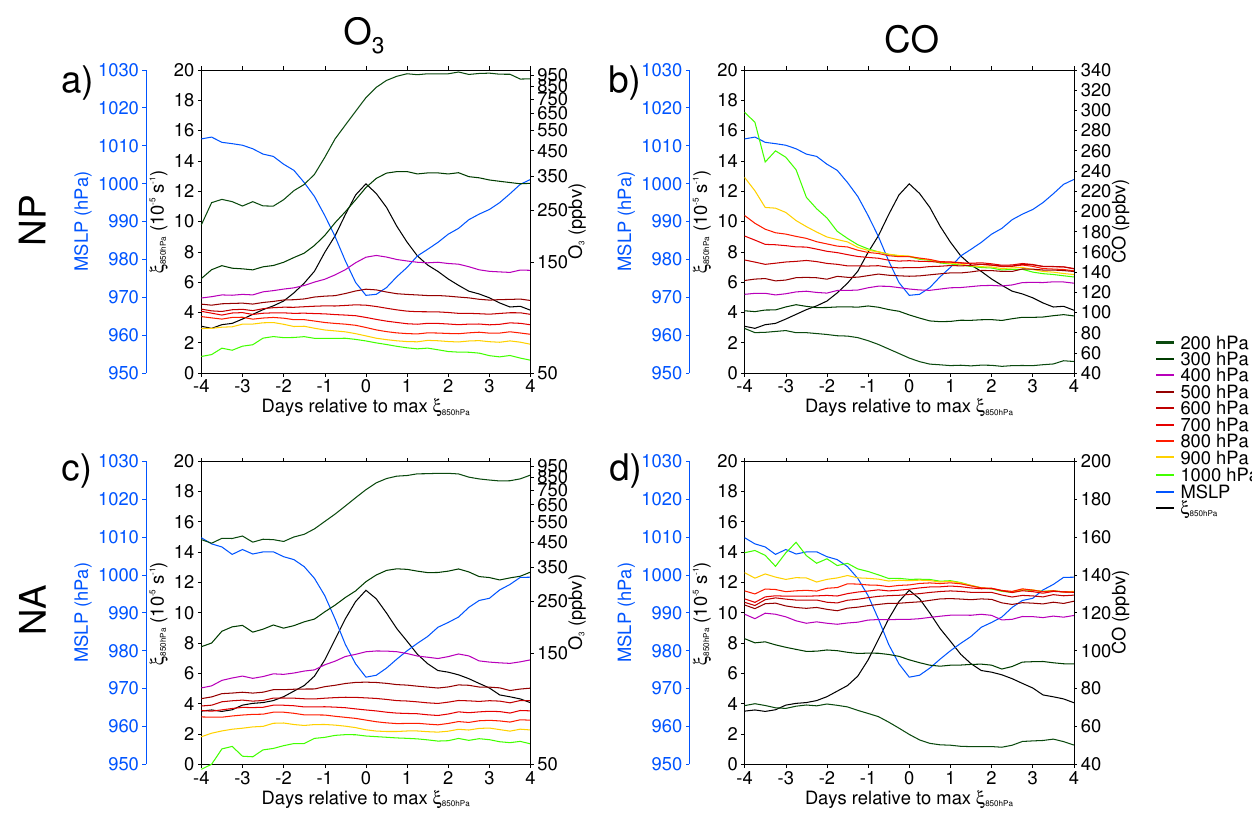
Figure 2. Life cycle of the 95th percentile MAM storm tracks during 2003–2012 for (a, b) NP and (c, d) NA with composite maximum ζ 850 (black line), storm-centered composite MSLP (blue line), and storm-centered composite (a, c) aavg-O 3 and (b, d) aavg-CO for nine atmospheric pressure levels (different colored lines). Time steps are every